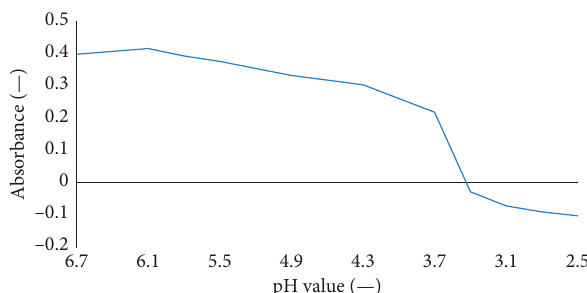
Figure 5: The pH effect on Al-ECR 3 signal intensity: acetate buffer 10 (0.2M Al 3+ (7.4 10 · ·